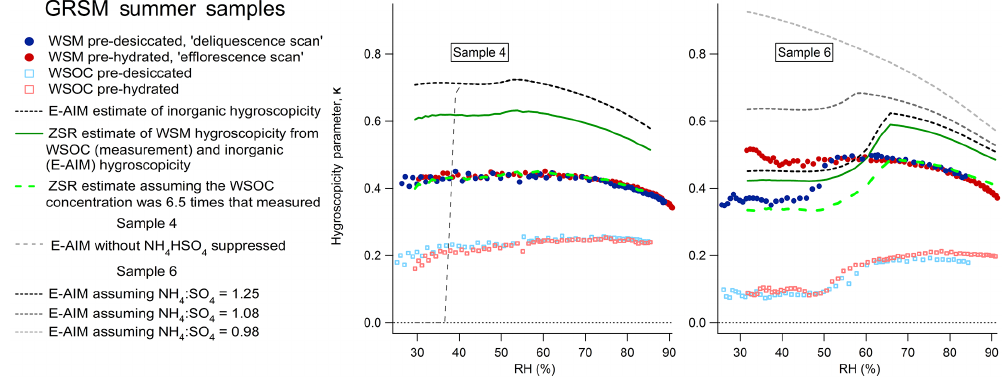
Figure 6. Contrasting expected and measured WSM hygroscopicity for samples taken during GRSM